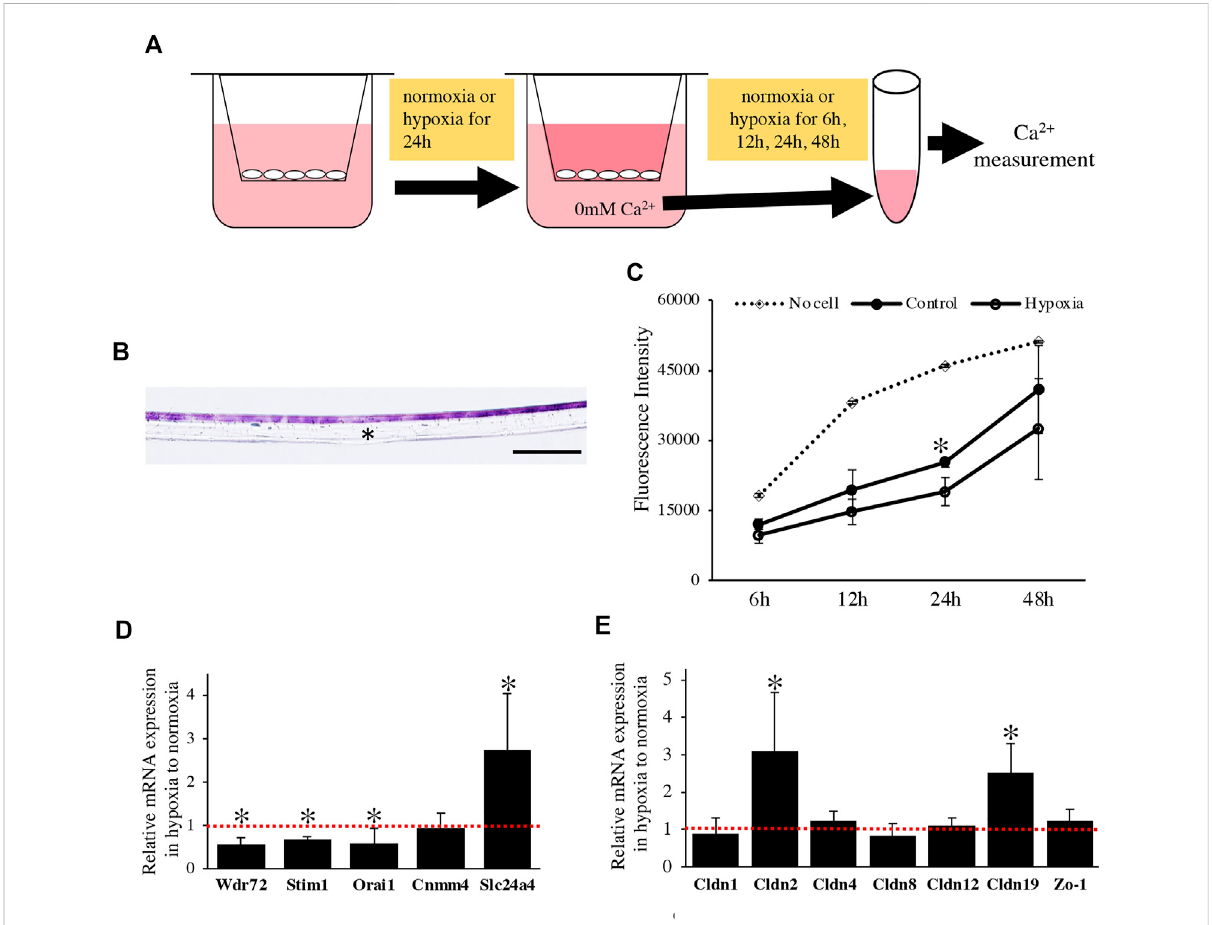
FIGURE 6 The effect of oxygen-mediated energy metabolic shift on Ca 2+ transport of HAT7 cells. (A) The experimental procedure for in vitro calcium transport assay. For more detailed information, see the materials and methods section. (B) HE staining of HAT7 cells cultured on Transwell fi lter in cross-section. (C) Changesovertime intheamountofcalciuminthelowerchamber.Calcium wastransferredfromtheupperchambertothelower chamber through HAT7 cells cultured in normoxia or hypoxia. n = 3. (D,E) Relative expression of target genes in HAT7 cells under hypoxia for 48 h to normoxia; n = 3. Data are represented as their mean ± SD. * p < 0.05 (unpaired two-tailed Student ’ s t -test). Scale bars, 100 μ m (B)